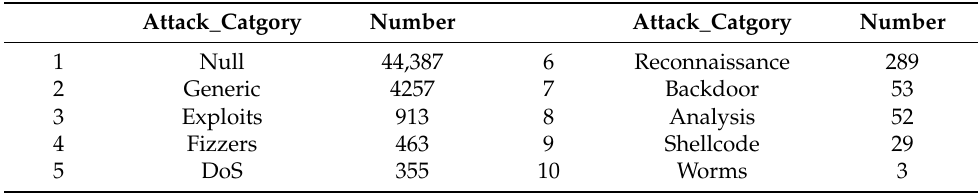
Table 3. Distribution of alarm labels in 50,801 pieces of data.